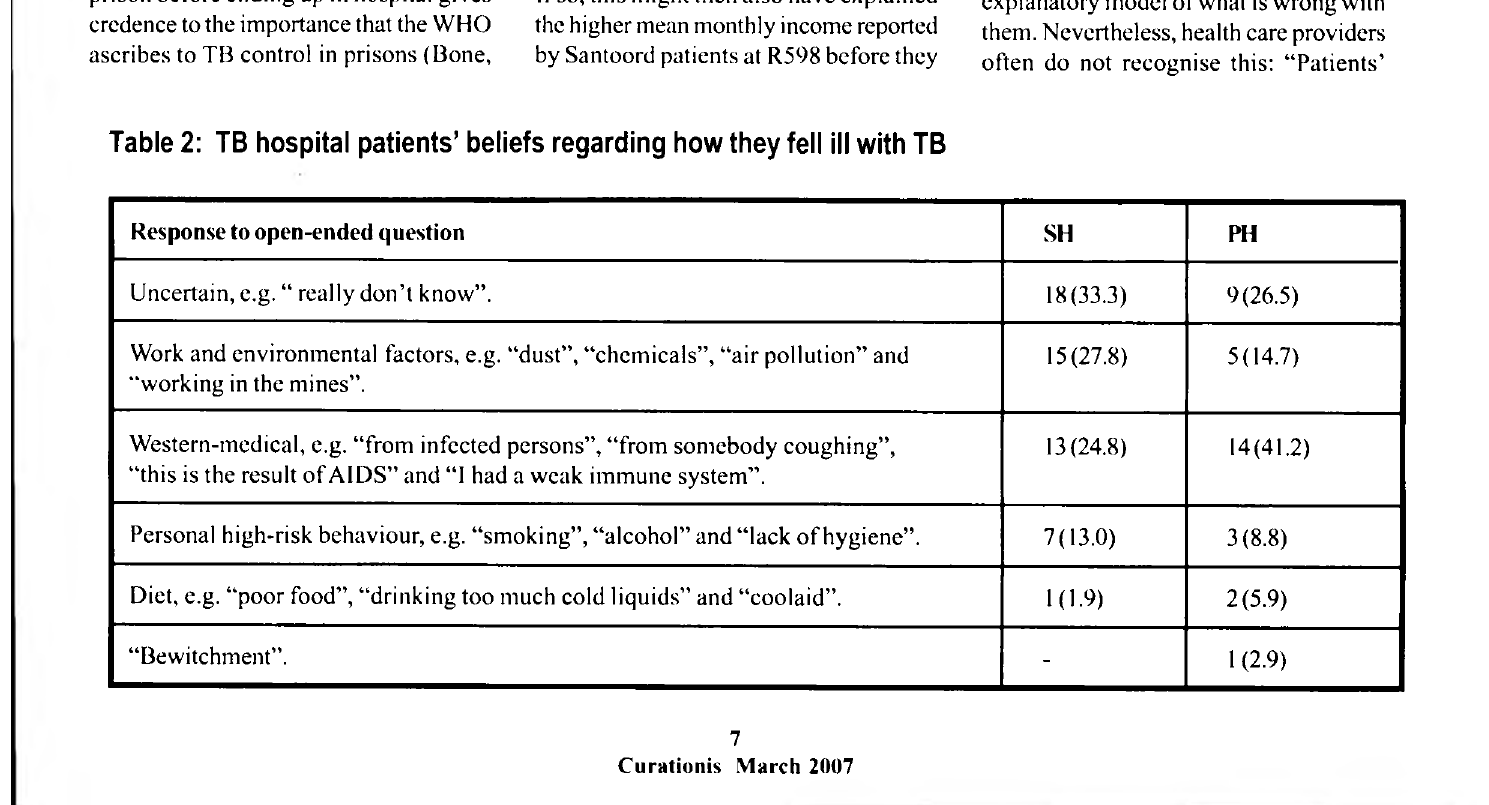
Table 2: TB hospital patients’ beliefs regarding how they fell ill with TB Response to open-ended question Uncertain, e.g. “ really don’t